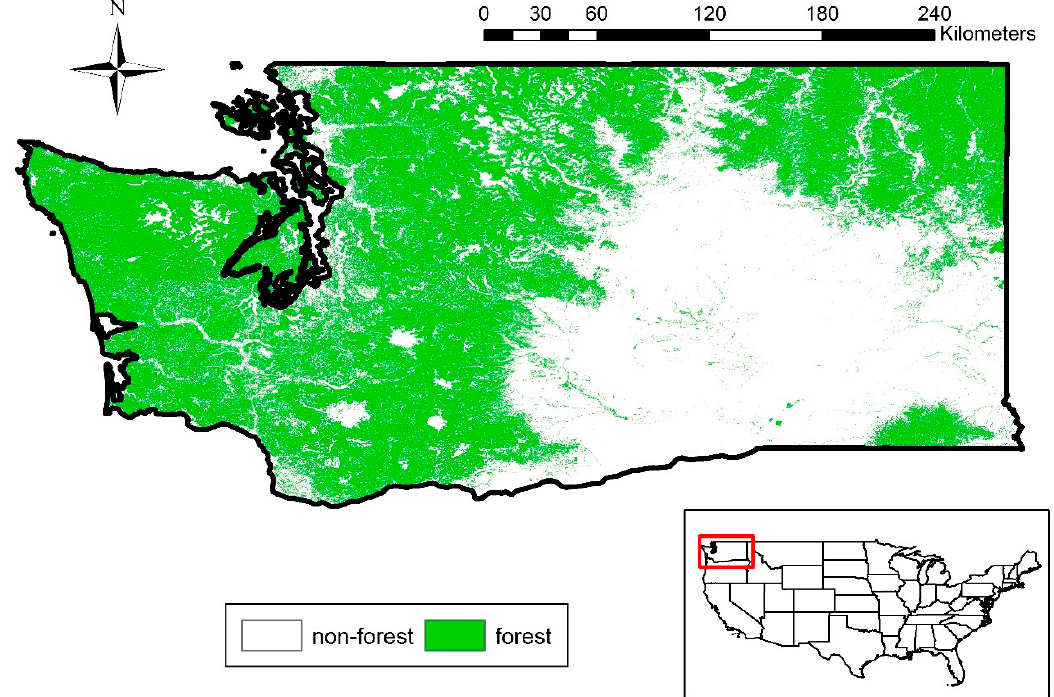
Figure 1. Forest and non-forest conditions in Washington State, and the location of Washington State relative to the conterminous relative to the conterminous USA.